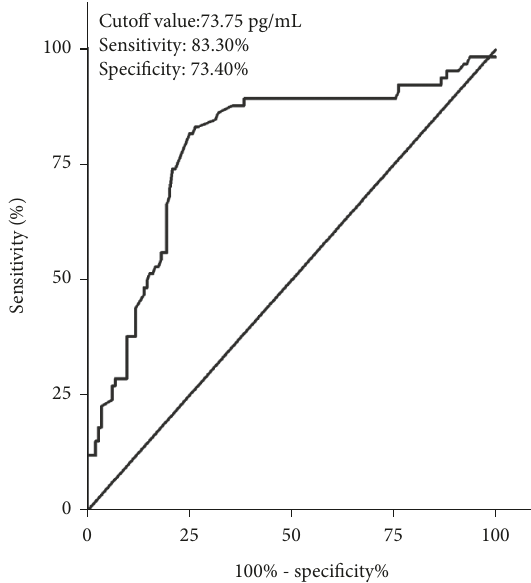
Figure 5: ROC curve analysis regarding predictive value of serum IL-12 levels for early neurologic deterioration after intracerebral hemorrhage.